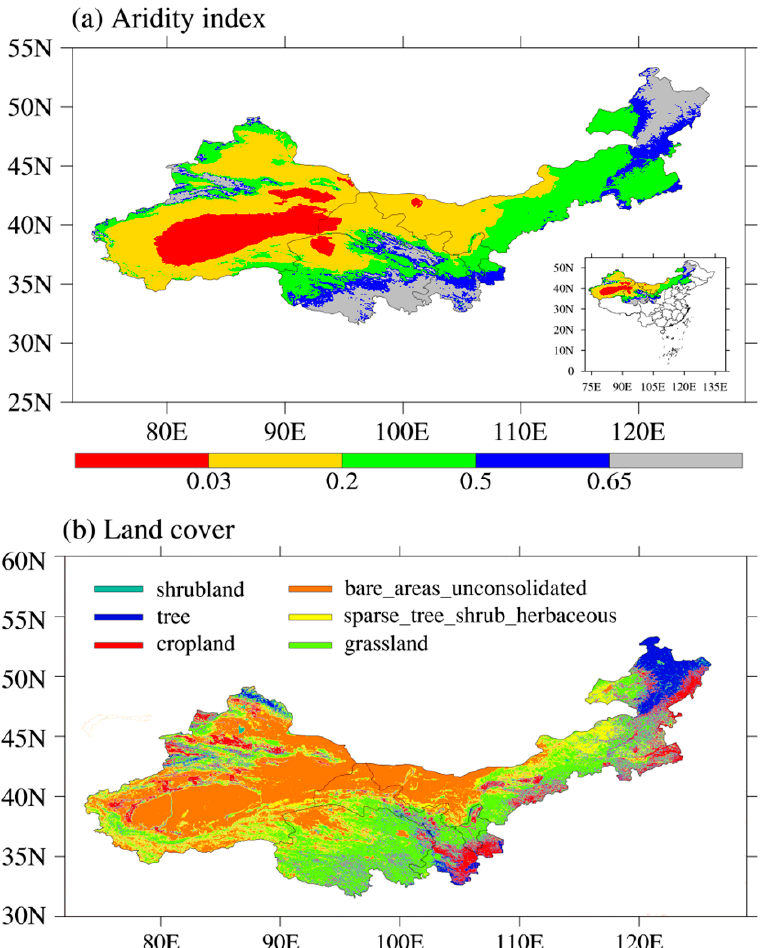
Figure 1. Graphical representation of the ( a ) aridity index (AI) and ( b ) land cover in the study area. For ( a ), colors, except gray, indicate regions in the drylands, and gray indicates the non-drylands, where AI is greater than 0.65. AI < 0.03, 0.03 ≤ AI < 0.2, 0.2 ≤ AI < 0.5, and 0.5 ≤ AI < 0.65 represent hyper-arid, arid, semi-arid, and dry sub-humid regions, respectively. For ( b ), land cover data are from the Global ESA CCI land cover classification map (http://www.esa-landcover-cci.org/ (accessed on 25 July 2021)).